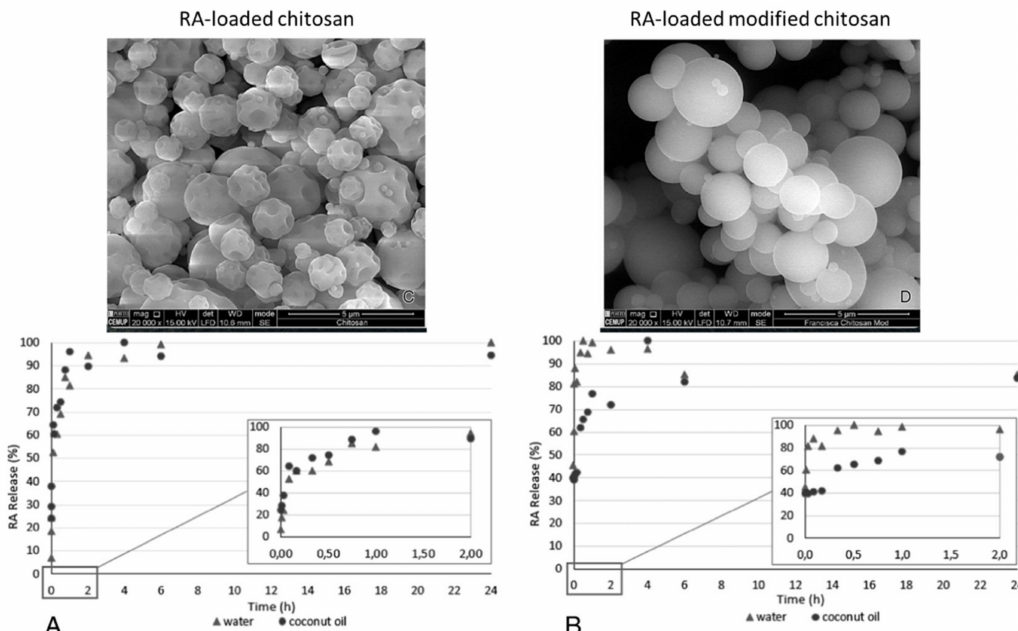
Figure 5. SEM micrographs and RA release profile in water and coconut oil of RA-loaded chitosan ( A ) and RA-loaded modified chitosan ( B ) microparticles (adapted from Casanova et al. [91], copyright 2016